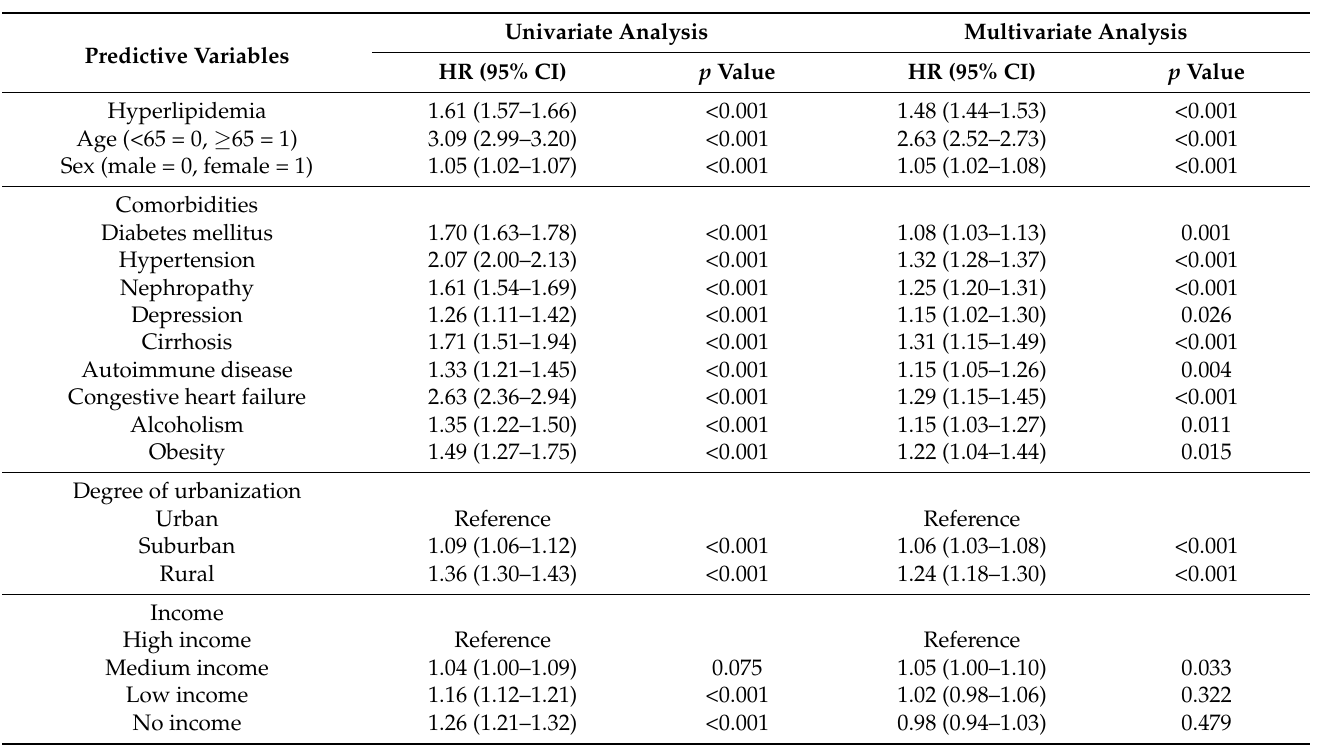
Figure 1. Cumulative incidence of newly diagnosed chronic obstructive pulmonary disease (COPD) in patients with (solid line) and without (dashed line) hyperlipidemia. Table 3. Analyses of risk factors for chronic obstructive pulmonary disease in patients with and without